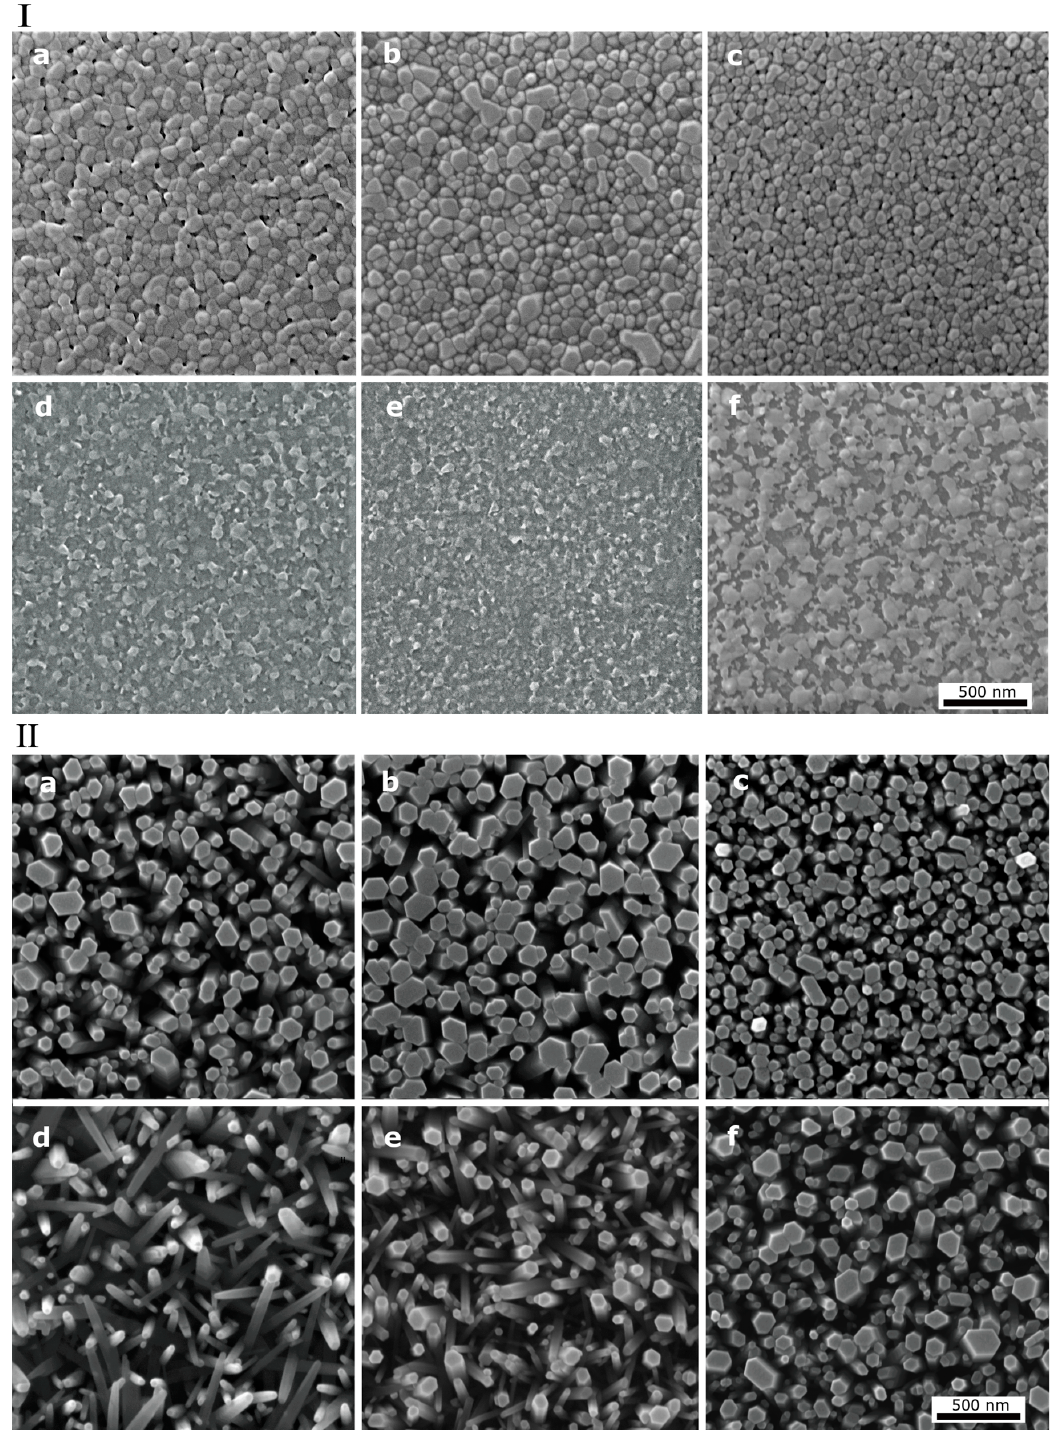
Figure 1. ( Ⅰ ) SEM images of the ZnO seed layers with different preheating temperatures and annealing conditions: ( a – c ) preheated at 300/350/400 °C and annealed in the air atmosphere at 600 °C; ( d – f ) preheated at 300/350/400 °C and annealed in the Ar atmosphere at 800 °C. ( Ⅱ ) Nanorods grown on corresponding seed layers.